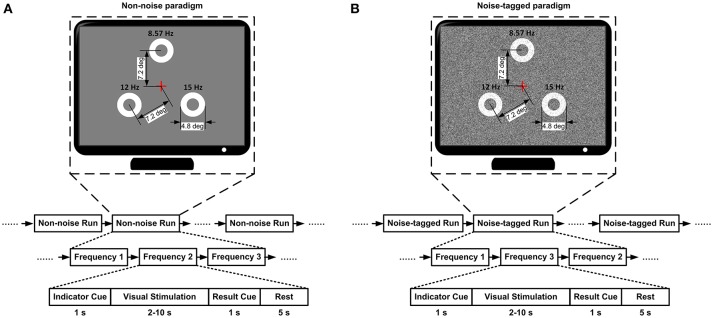
The overall BCI experimental protocol. (A) The non-noise BCI session. (B) The noise-tagged BCI session. For both the non-noise and noise-tagged sessions, the three targets were masked by noise spots based on background stimulation with standard deviations 0 and 40 of gray-scale level, respectively. Each run contained 15 trials. Each trial started with a visual cue that appeared for 1 s above a specific target to instruct subjects to pay attention to that target. Following the cue offset, three motion-reversal targets were simultaneously displayed on the screen for 2–10 s. Subjects were asked to maintain attention and watch closely the indicated target. Once the target was identified, another visual cue was presented in the center of the screen for 1 s to display the result and the trial was terminated. After the stimulus was offset, a homogenous gray screen was presented for 5 s before the next trial began.